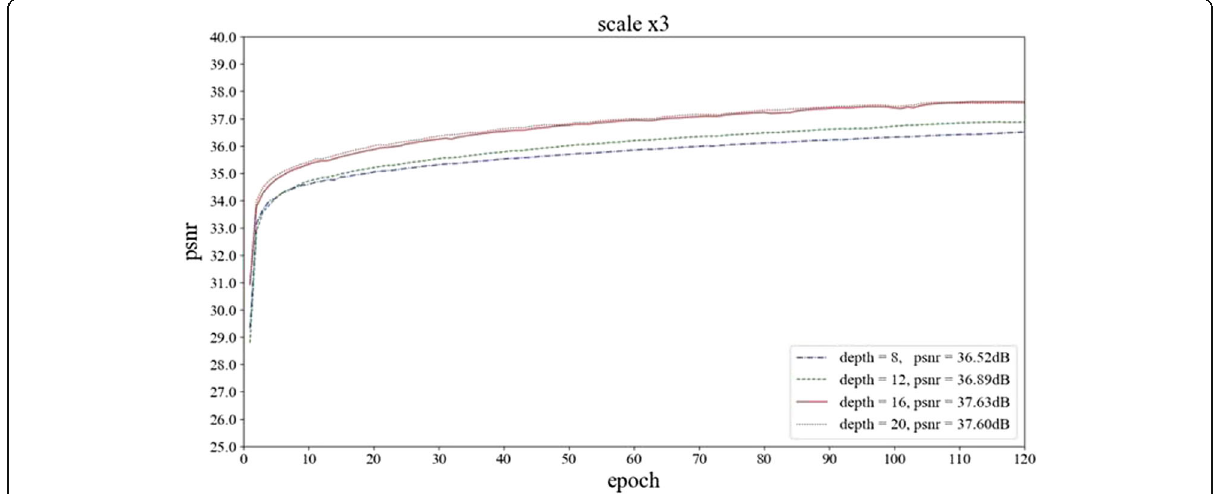
Fig. 7 The experimental results of model with different network